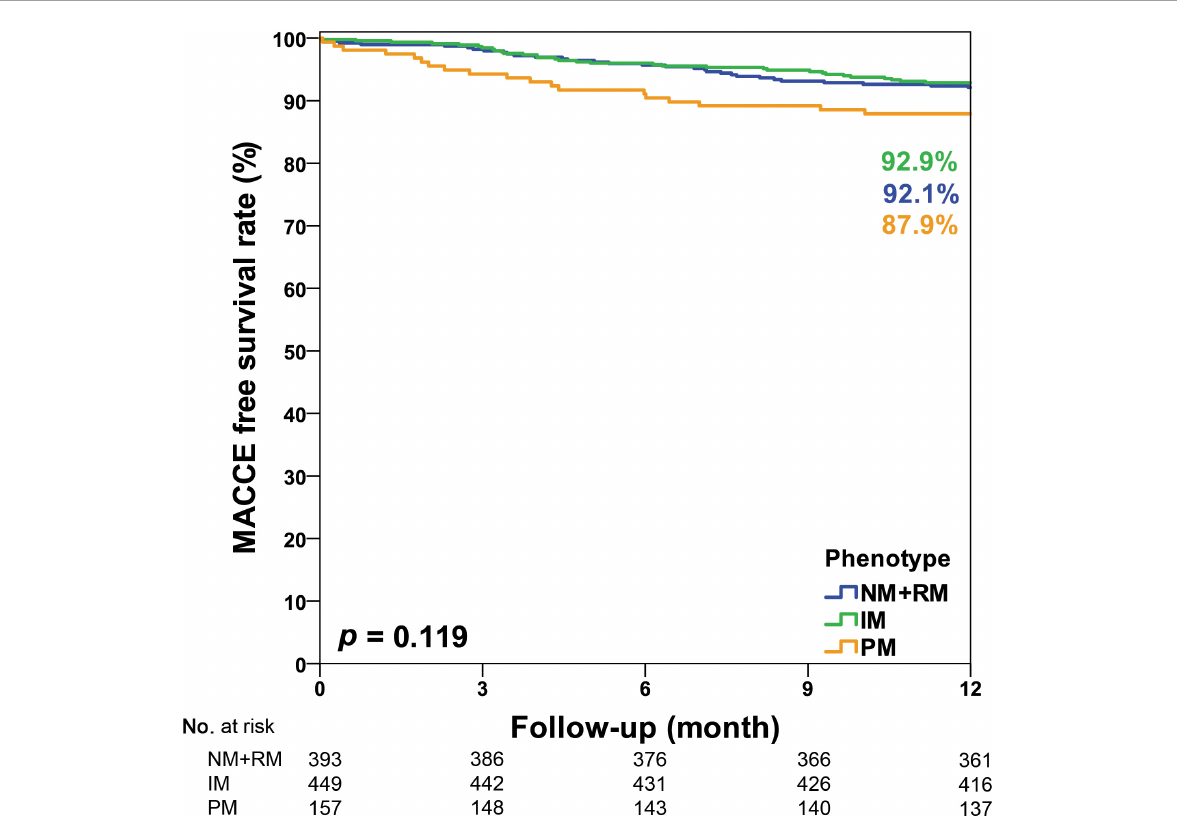
FIGURE2 Kaplan–Meier curve of the cumulative incidence of major adverse cardiovascular and cerebrovascular events (MACCE) at the 1-year follow-up stratified based on the CYP2C19 phenotype of all study participants. IM, intermediate metabolizer; NM, normal metabolizer; PM, poor metabolizer; RM, rapid